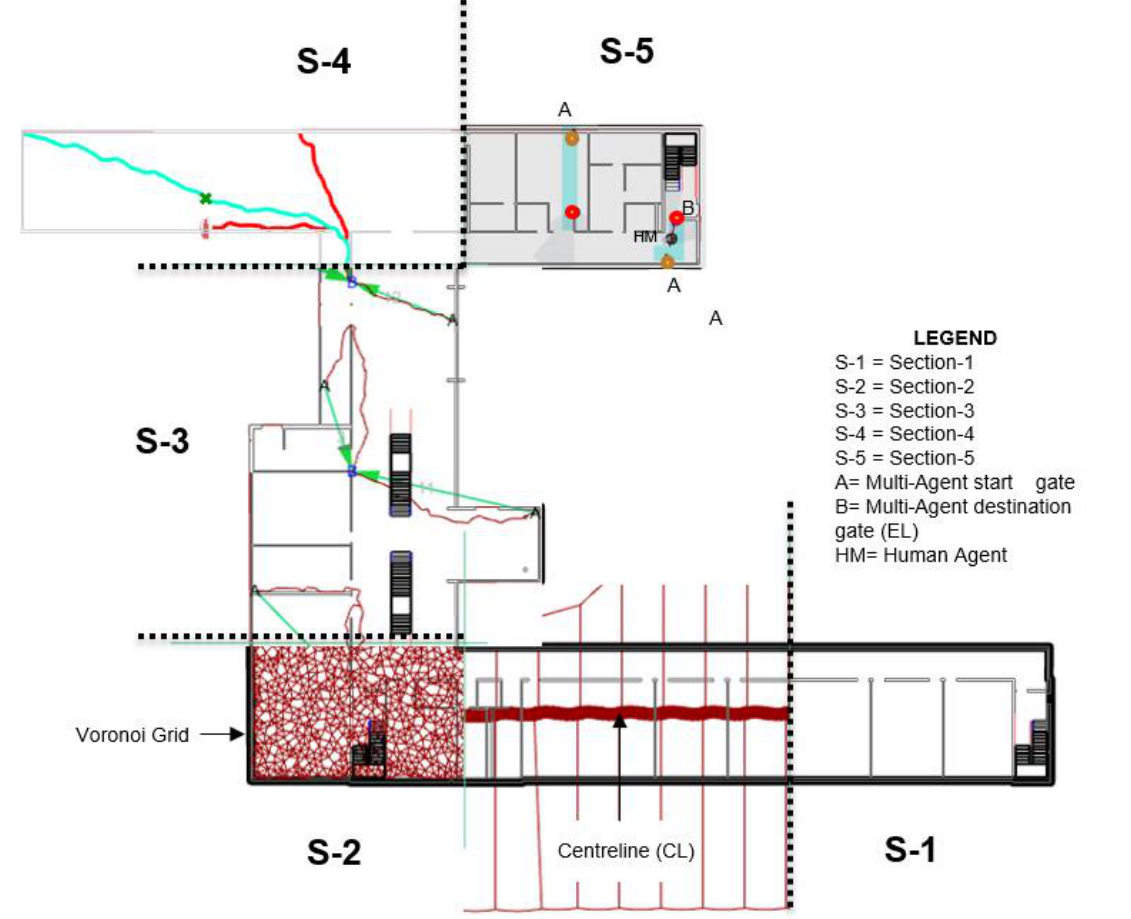
Figure 5. Graphic illustration of the process steps followed in the case study